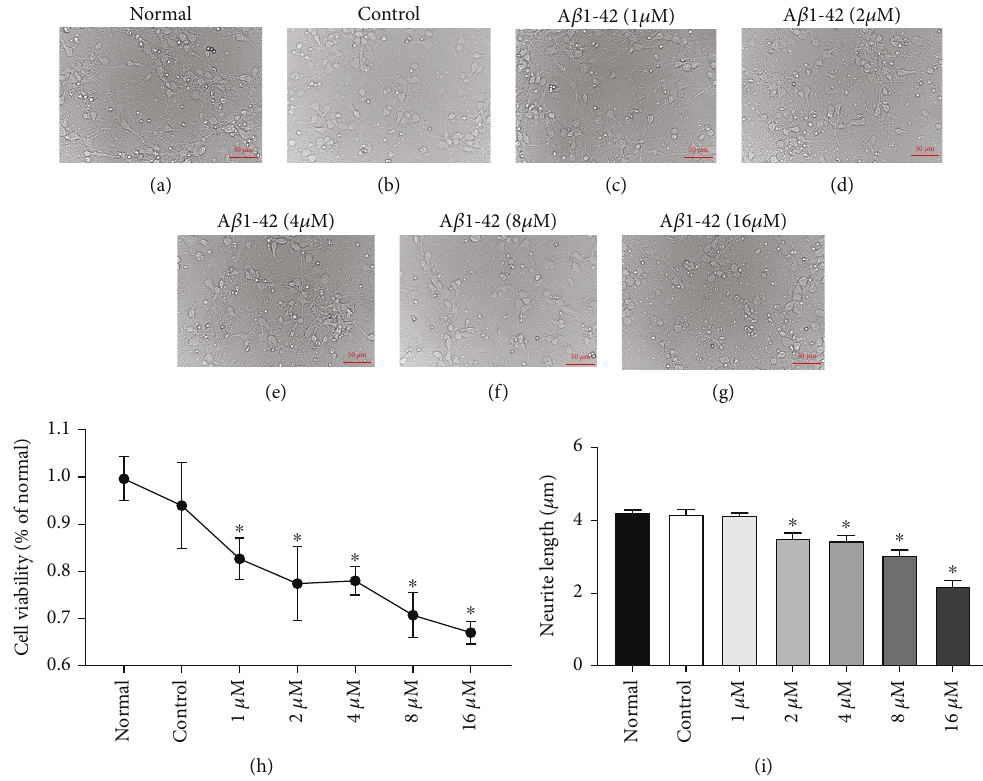
Figure 1: A β 1-42 oligomer decreased the cell viability of neuronal cells (scale bar: 100 μ m). (a) Bright fi eld micrograph of normal neuronal cells without treatment. (b) Bright fi eld micrograph of control neuronal cells treated with the solvent DMSO. (c – g) Bright fi eld micrograph of neurons treated with gradient concentration (1 μ M/2 μ M/4 μ M/8 μ M/16 μ M) of A β 1-42 oligomer. (h) The cell viability of neuron cells was quanti fi ed by MTT assay ( n = 6 ). ∗ Versus the control group, P < 0 : 05 . (i) The length of neuronal axon between the treatment groups were quanti fi ed ( n = 6 ). ∗ Versus the control group, P < 0 : 05 . Normal group: normal cultured neurons without treatment; control group: neurons treated with solvent of Nav β 2 protein ( ∗ P < 0 : 05 , Figure 2(a)). In contrast, the Nav β 2 protein level in the A β 1-42+si-Nav β 2 group was sig-